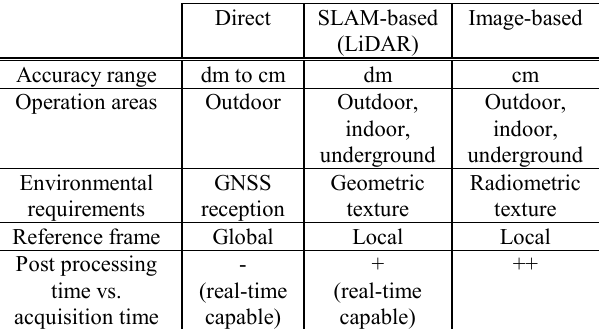
Table 1. Comparison of the discussed georeferencing